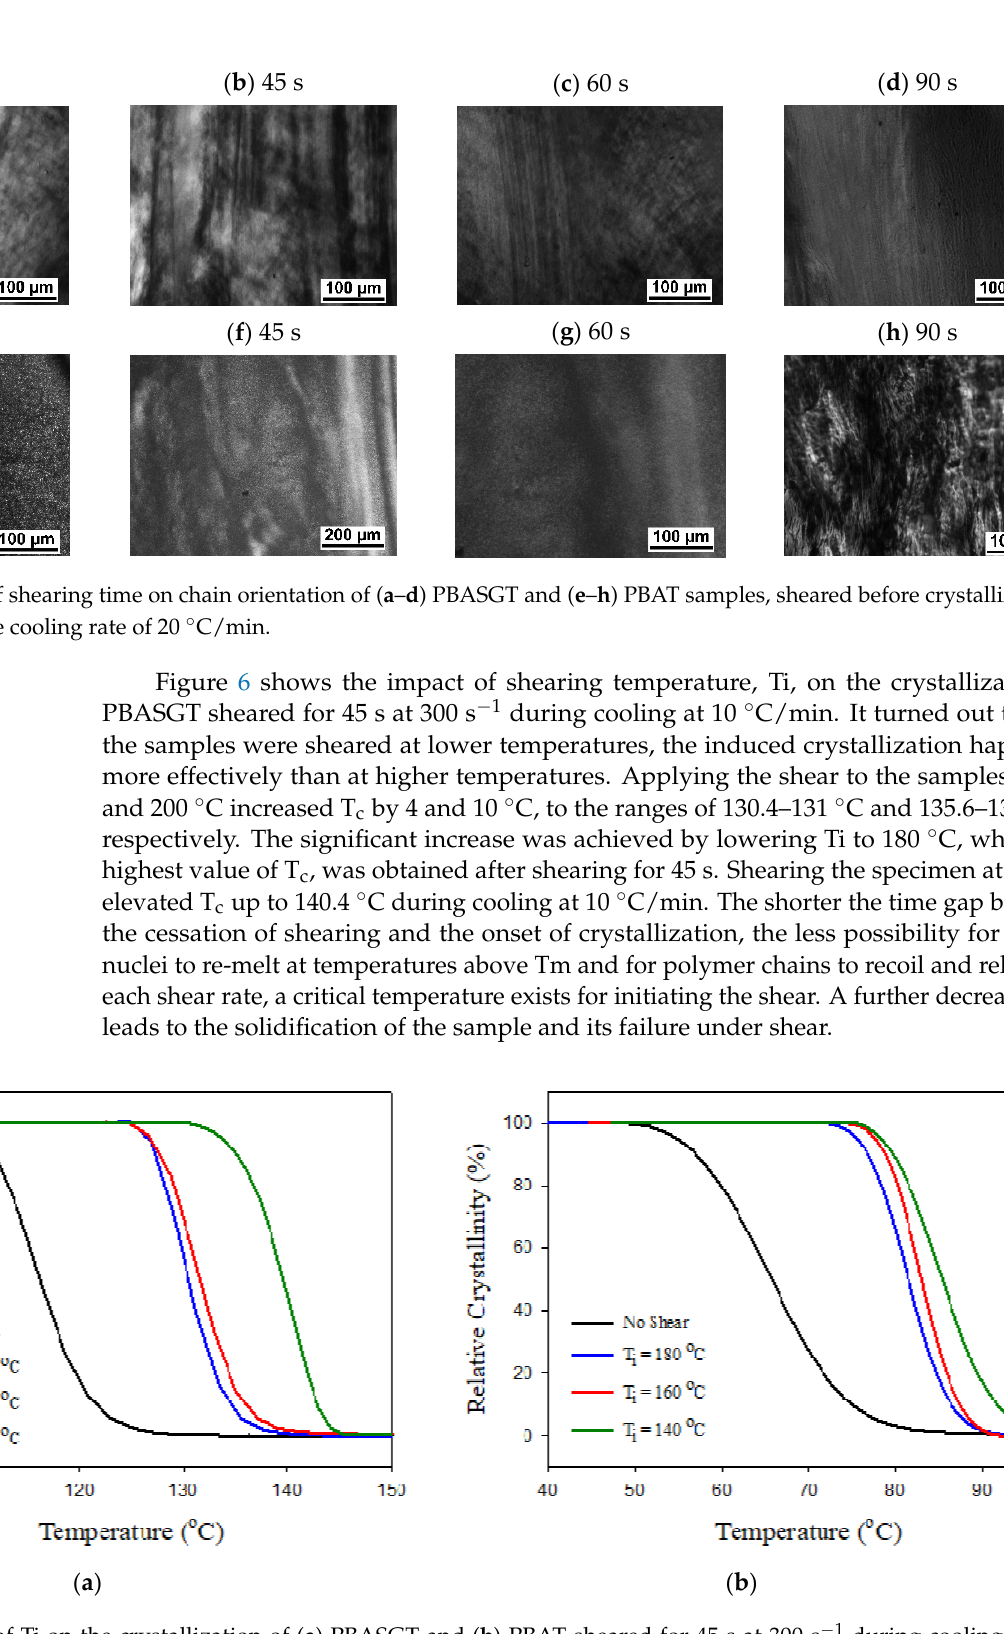
Figure 6. Effect of Ti on the crystallization of ( a ) PBASGT and ( b ) PBAT sheared for 45 s at 300 s −1 during cooling at 10 °C/min.